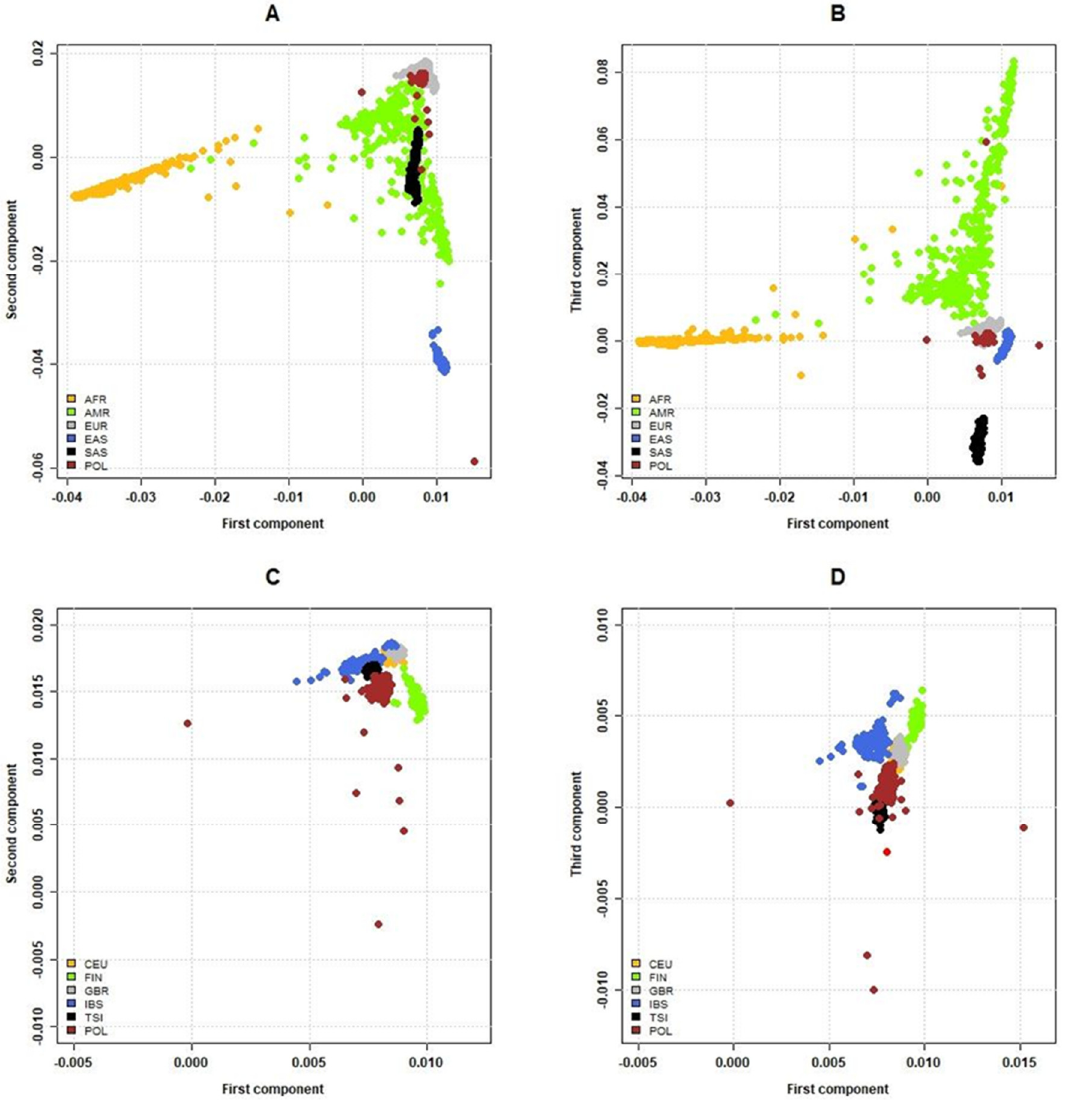
Figure 3. Clustering of samples among the global and European subpopulations based on the random forest and PCA predictions. Comparison of ( A ) the first and second principal components for continental populations, ( B ) the first and third principal components for continental populations, ( C ) the first and second principal components for the European subpopulations, and ( D ) the first and third principal components for the European subpopulations. Analysed populations: Utah residents (CEPH) with Northern and Western European ancestry (CEU), Finnish in Finland (FIN), British in England and Scotland (GBR), Iberian in Spain (IBS), and Toscani in Italy (TSI).